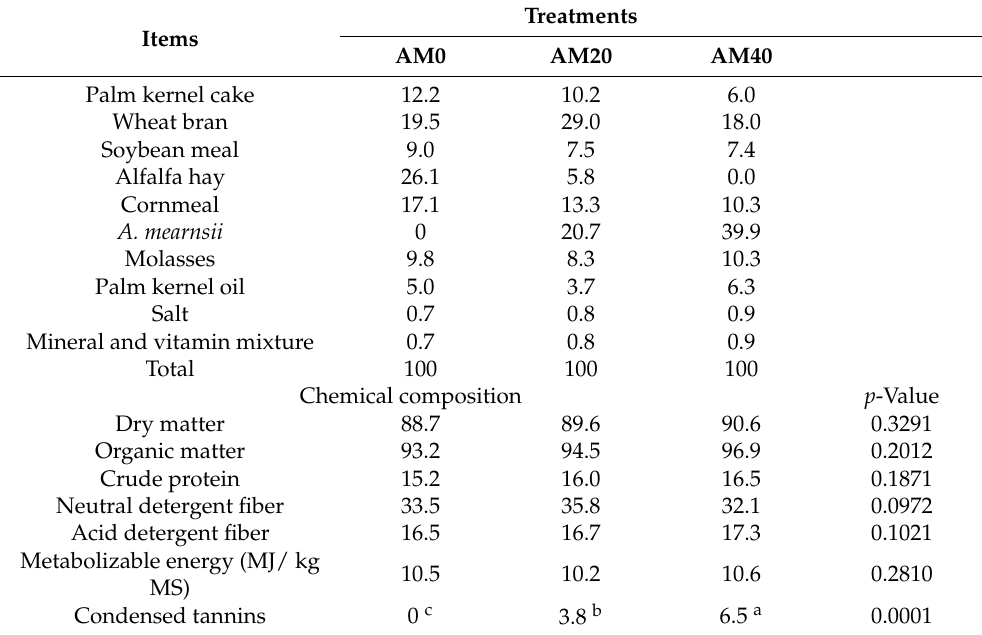
Table 1. Chemical composition of diets with increasing levels of Acacia mearnsii (AM in % except where otherwise